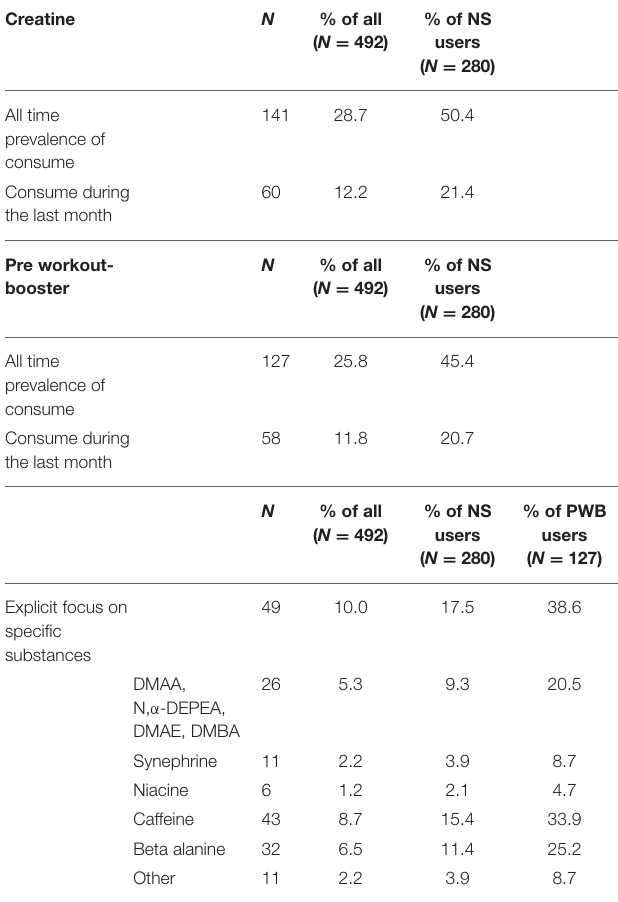
TABLE 4 | Prevalence of creatine and pre workout booster (PWB)